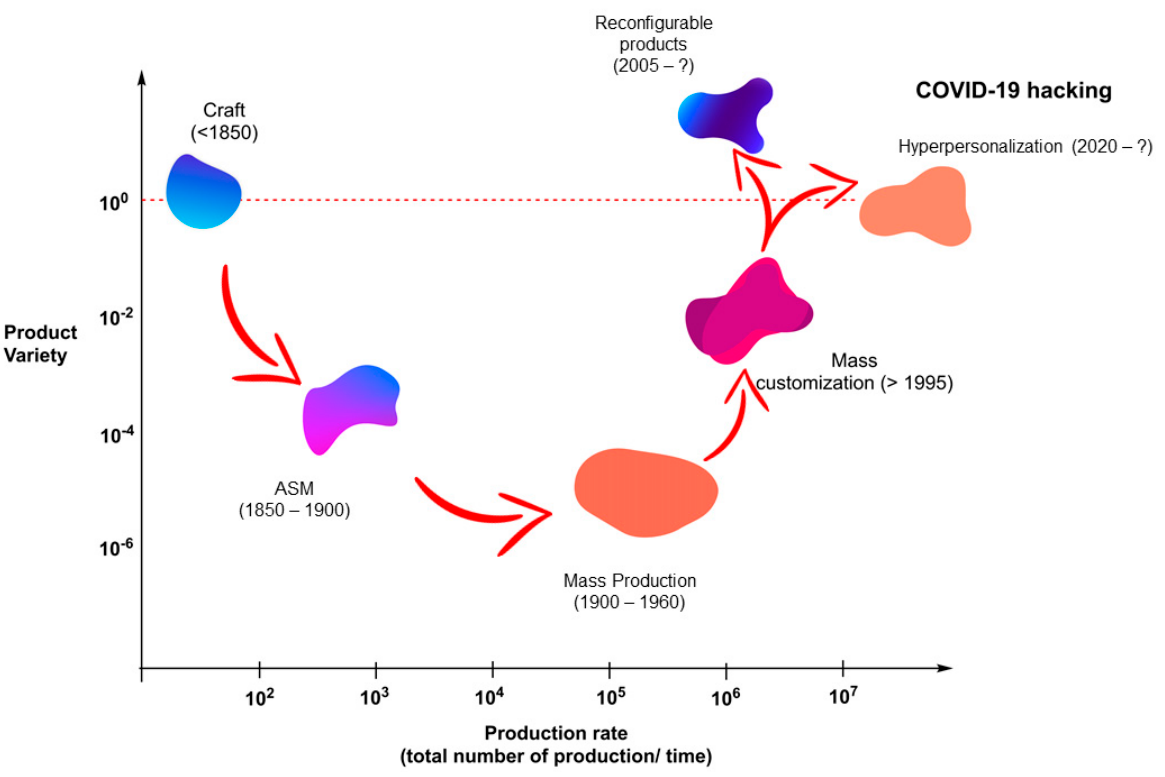
Figure 5. Growth of the hyper-personalization markets.